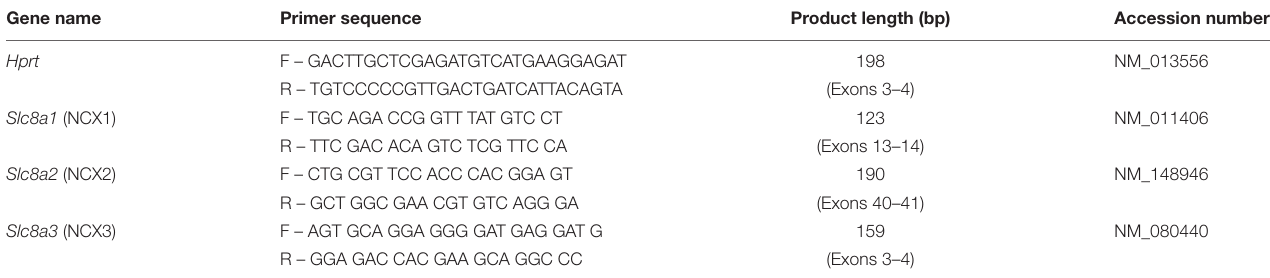
TABLE 1 | List of primers used for PCR and qPCR.